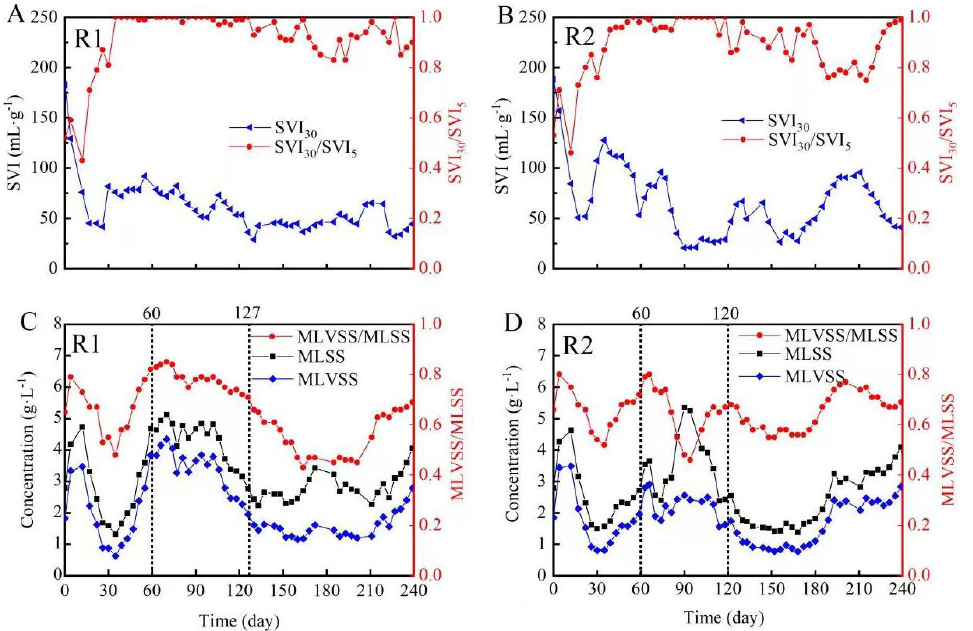
Figure 1. SVI and MLSS profiles in R1 and R2 during the long − term operation period. ( A , B ) SVI 30 and SVI 30 /SVI 5 and ( C , D ) biomass concentration of the aerobic granular sludge. Food-to-microbial biomass ratio (F/M) is the substrate loading per unit biomass for wastewater treatment, which greatly affects the microbial growth in aerobic granular